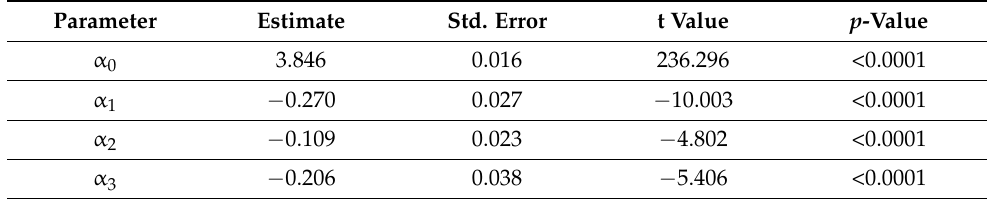
Table A2. Linear mixed effect model for modulus of elasticity—summary statistics of the fixed effects. p -values are approximated using the Satterthwaites’s method [20], AIC = 758.845, and standard deviation of the random effect equals